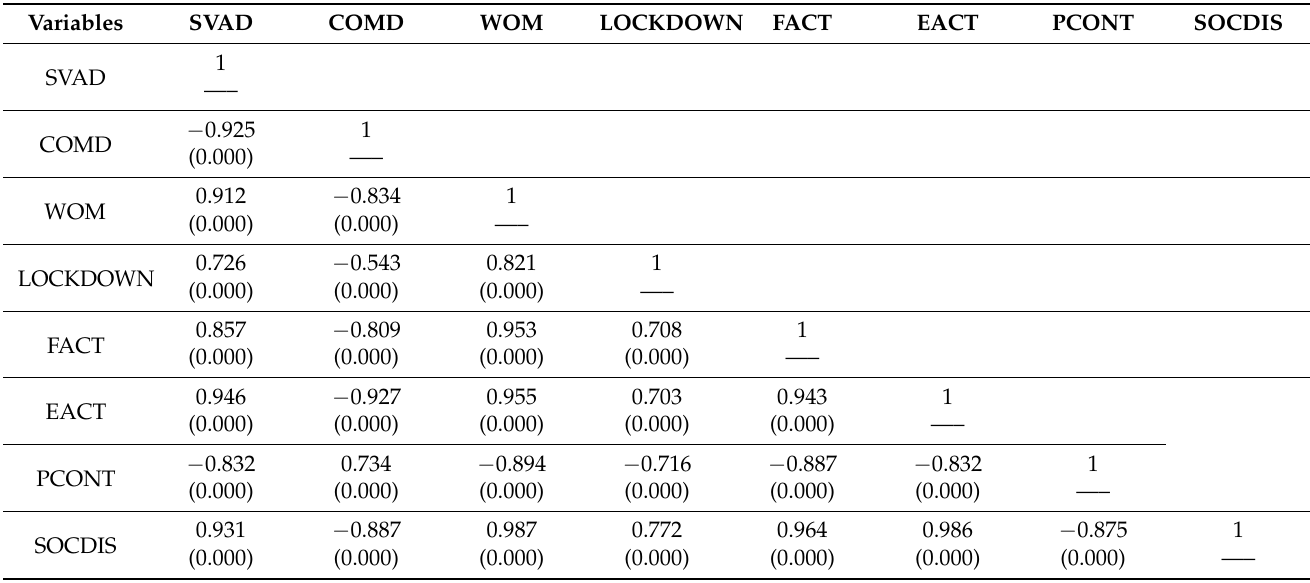
Table 3. Correlation Matrix.